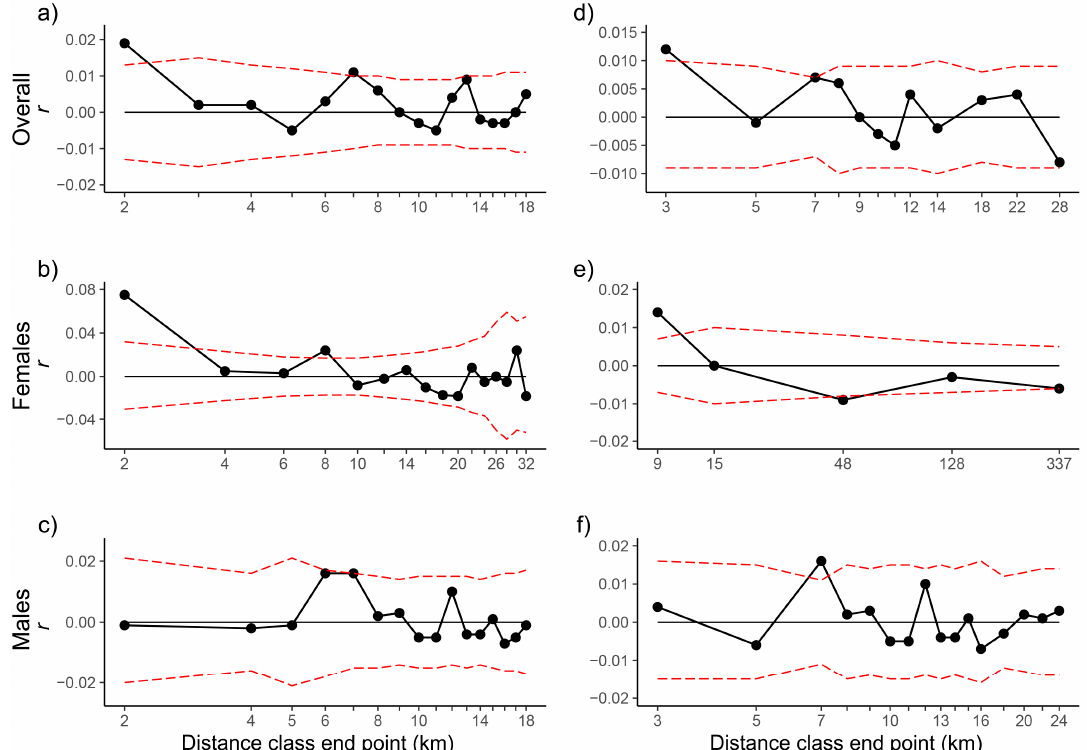
Figure 2. Spatial autocorrelation correlograms for all APNR + KNP adult samples - ( a ) and ( d ) - and separately for each sex (females: ( b ) and ( e ); males: ( c) and ( f ). r is the autocorrelation coefficient, a measure of the genetic similarity between pairs of individuals falling within a given distance class. The left plots show results using the same upper bound of 2 km for the first distance class and the right plots show results using a first distance class such that, for all adults and for adult females only (top two plots), it reveals the approximate geographic distance up to which positive spatial genetic structure was detectable. All distance classes in the correlograms contained more than 100 pairwise comparisons. The red dashed lines represent the 95% confidence envelope for the hypothesis of no spatial genetic structure as determined by permutation.